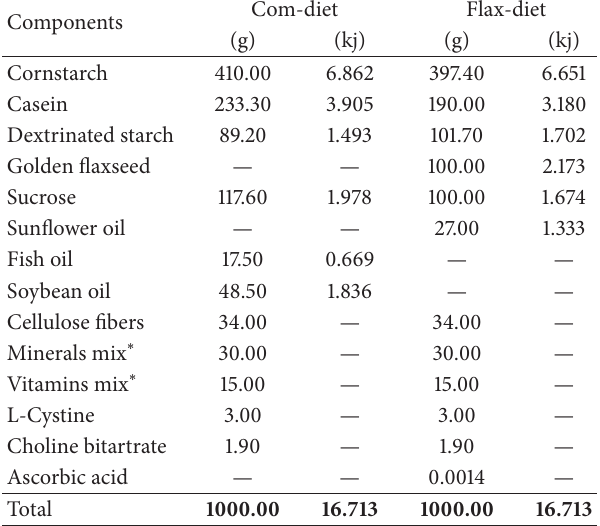
Table 1: Constituents of commercial diet (Com-diet) and diet sup- plemented with golden flaxseed flour and sunflower oil (Flax- diet). Values are given in g kg −1 of diet and the energy is given in kj kg −1 . ∗ Mixture of salts and vitamins used in the diet followed the recommendation of the AIN–93G